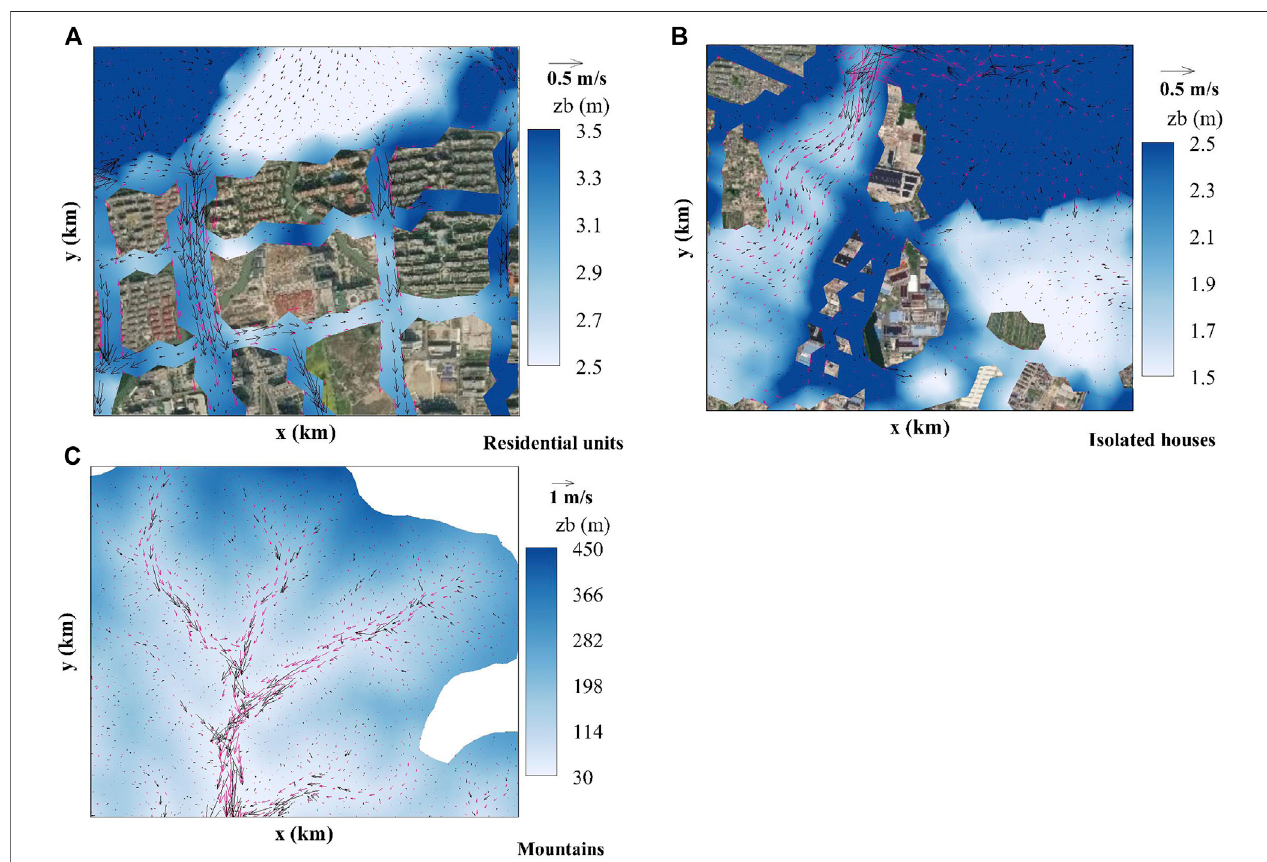
FIGURE 11 | Comparison of velocity vectors of the two models in. (A) residential units. (B) isolated houses, and (C) mountains.